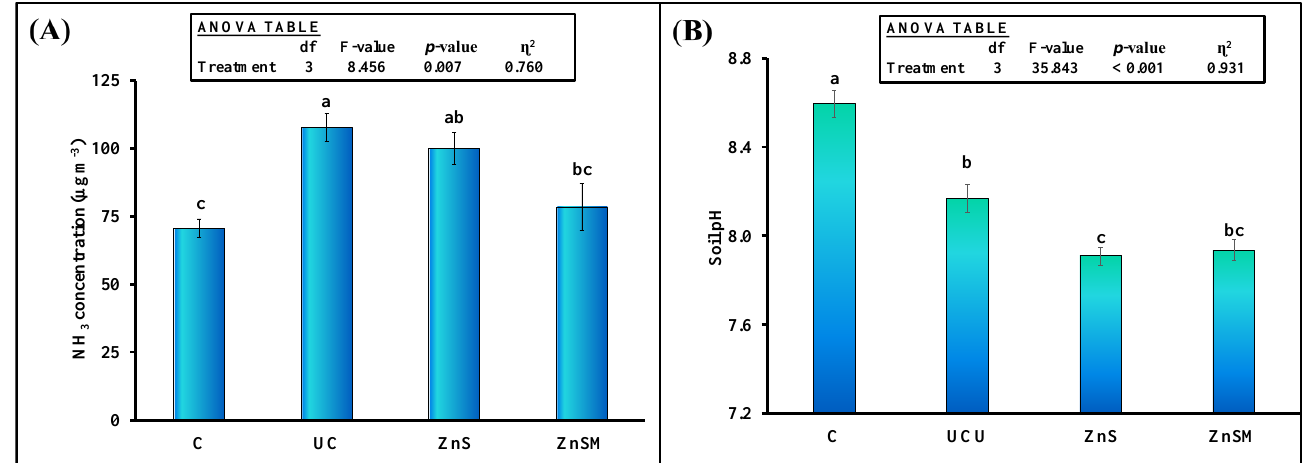
Figure 4. Mean ( n = 3) NH 3 concentration (µg m -3 ) ( A ) and soil pH ( B ) after application of uncoated urea (UCU) and urea granules coated with zinc sulphate (ZnS) and zinc sulphate plus molasses (ZnSM). C stands for untreated control treatment. Error bars showed standard errors (±1 SE) of the mean. Different small and capital letters show significant difference at 5% probability level. Inset represents ANOVA Table. Multiple comparisons among treatments were analyzed by Tukey’s HSD test.